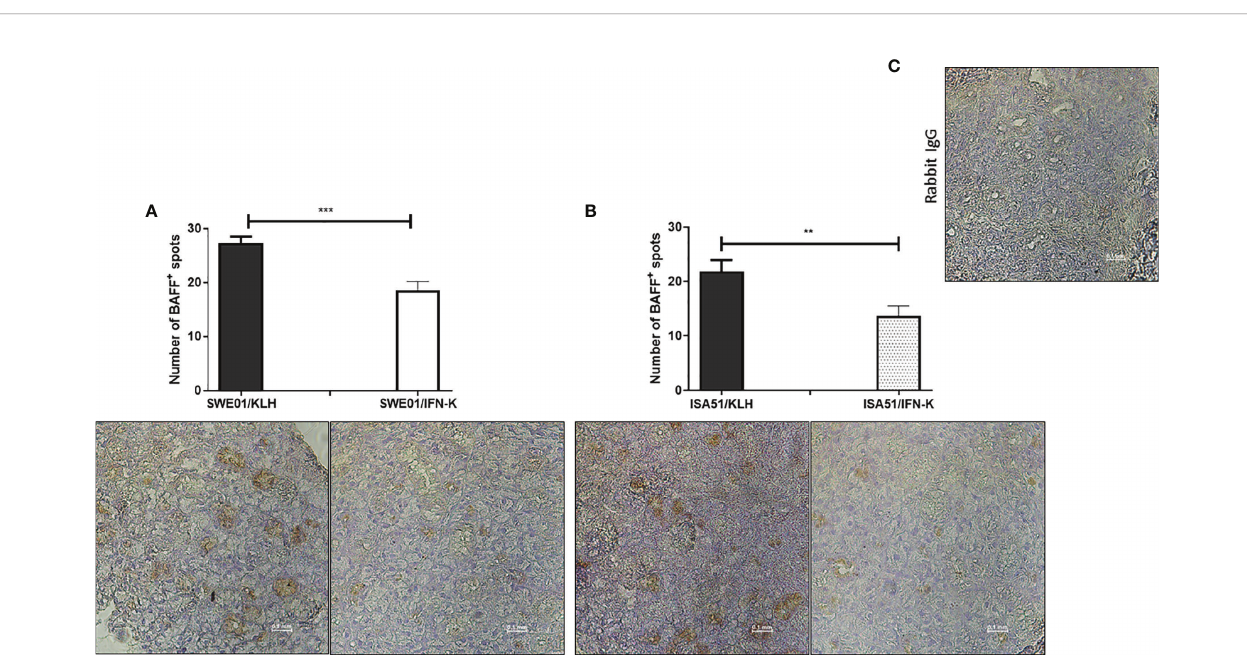
FIGURE 6 | In-situ reduction of B cell activating factor (BAFF) production. Local expression of BAFF was analyzed by immunochemistry in formalin- fi xed, paraf fi n- embedded submandibular glands (SMG) harvested at the end of follow-up in SWE01/KLH, SWE01/IFN-K, ISA51/KLH and ISA51/IFN-K mice (n=5 per group). BAFF- positive zones (brown spots) in SMG were counted out of 3 non-overlapping microscope fi elds (x40) per sample and compared between controls and treated mice in (A) SWE01 cohort and (B) ISA51 cohort. Representative images of BAFF-immunostained sections and (C) negative control (rabbit IgG) are shown (original magni fi cation x40). Error bars indicate mean ± S.E.M. **p < 0.01 and ***p <